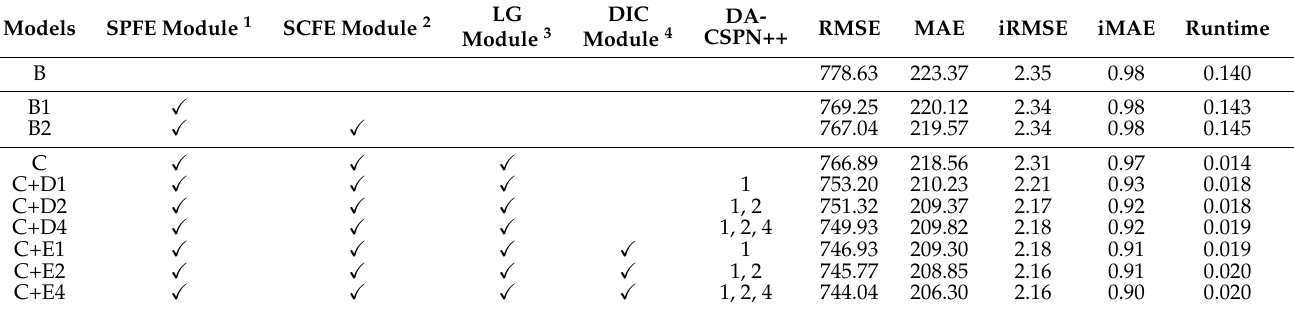
Table 1. Performance on the KITTI depth completion validation